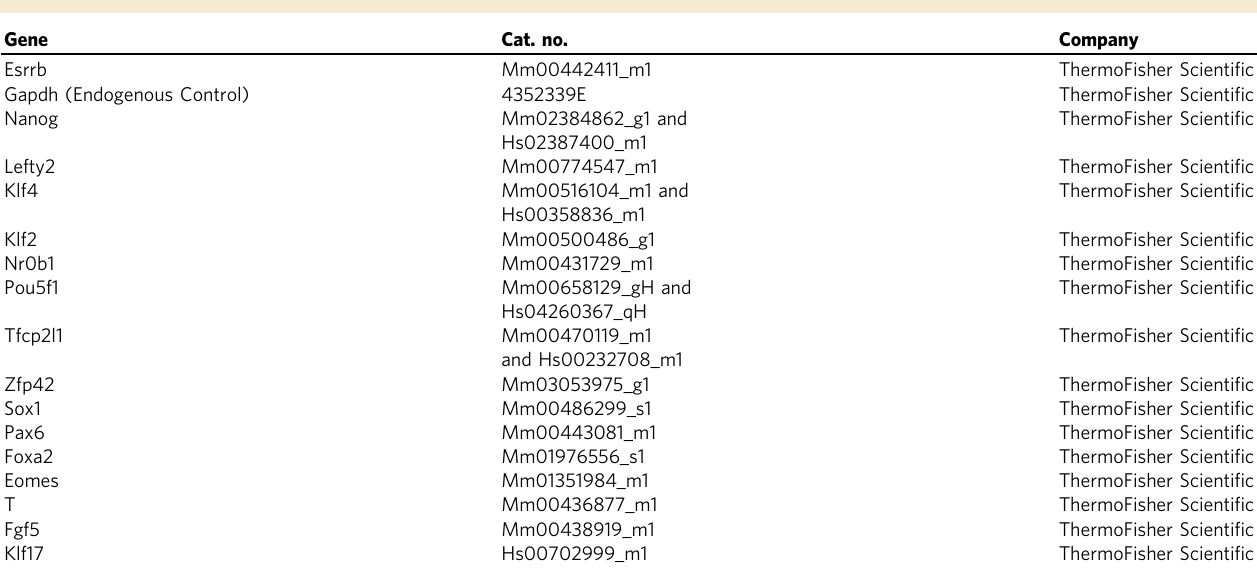
Table 2 List of probes for gene expression